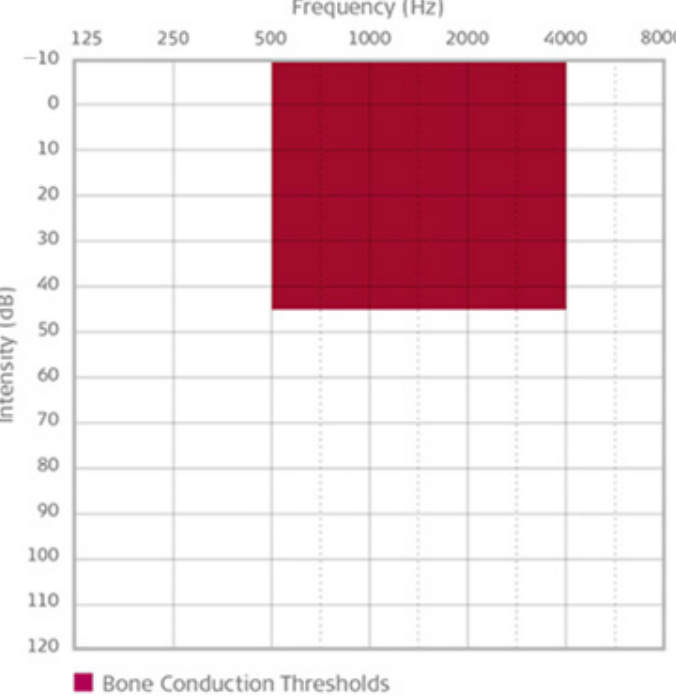
Figure 1. Indication range for bone conduction thresholds for the Bonebridge implant [19].